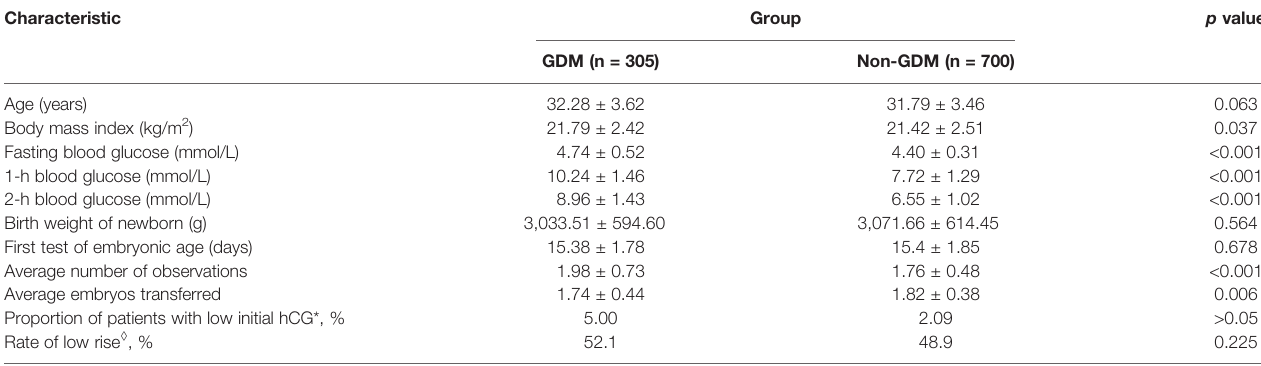
TABLE 1 | Basic characteristics of the GDM and non-GDM groups.